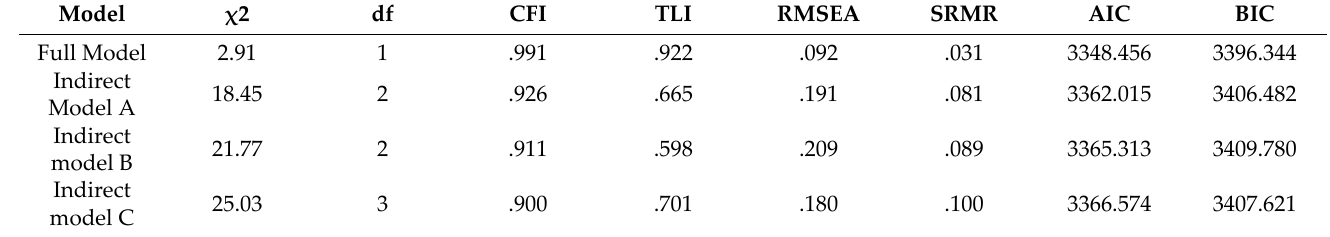
Table 3. Goodness‑of‑fit indexes and comparisons of different models of the relation between Chi‑